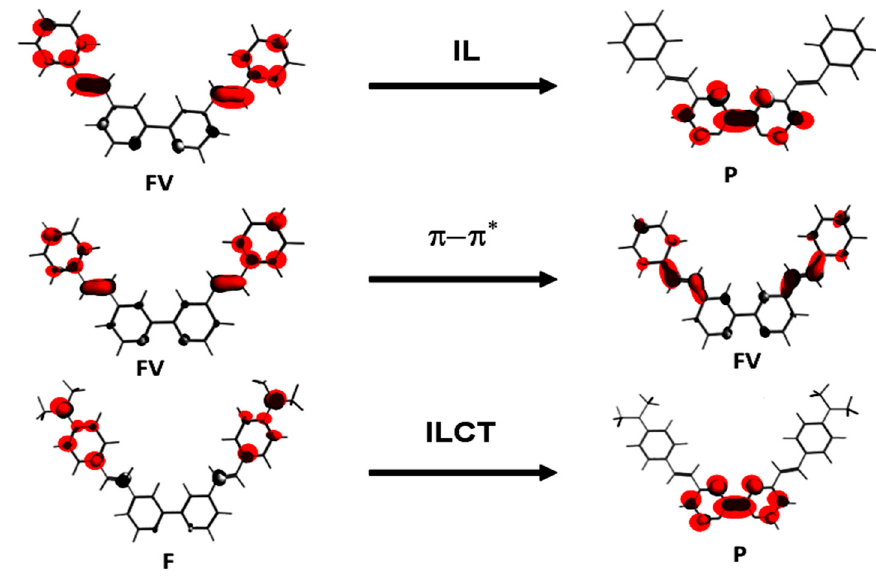
Figure 7. Types of electronic transition ocurring wihin the diferents fragments of LH and LN ligands. (IL: intraligand; ILCT: intraligand charge transfer.)